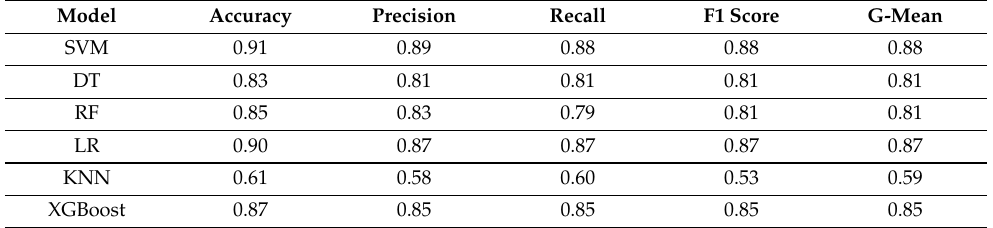
Table 12. The results of machine-learning models using BoW